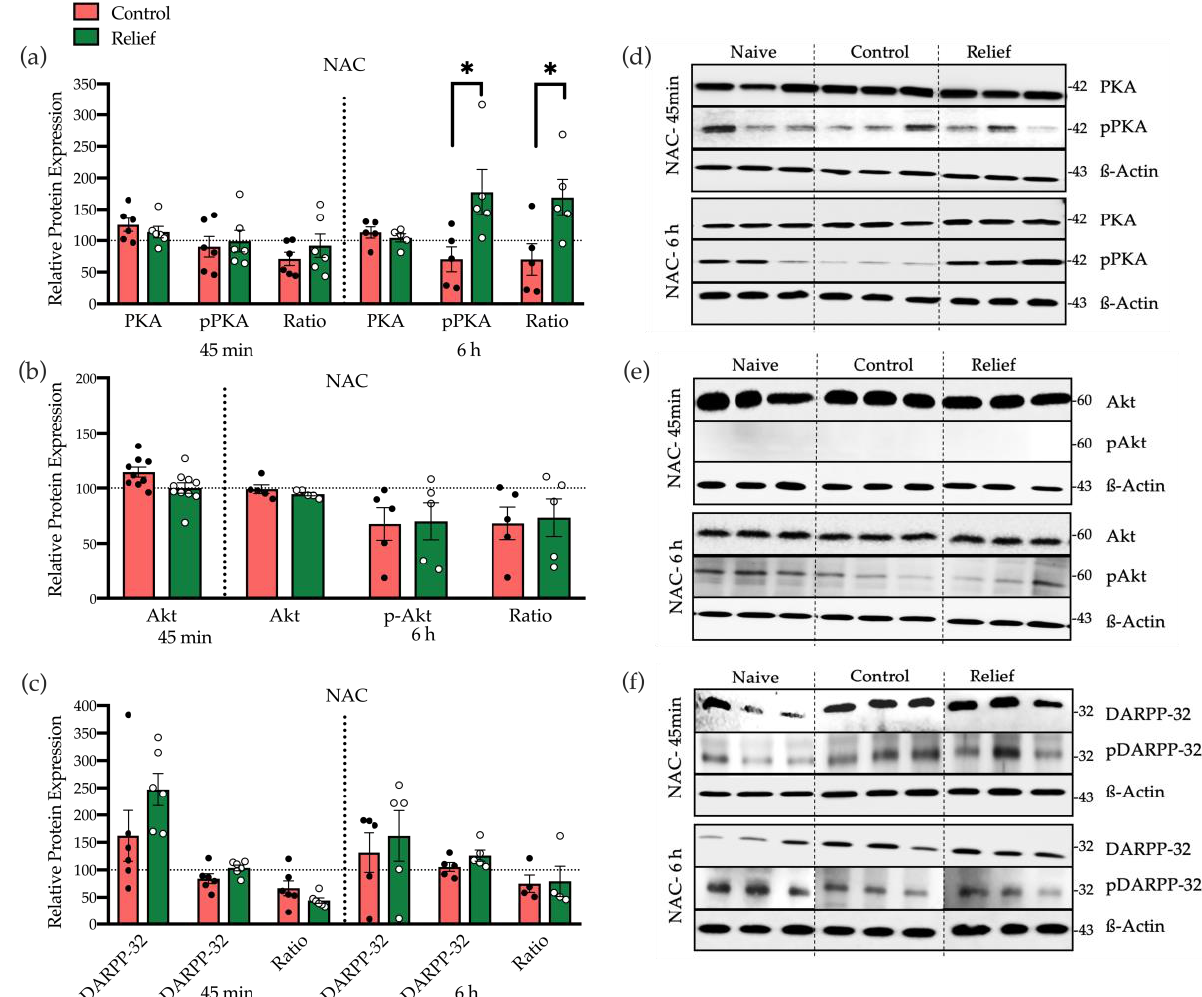
Figure 5. Expression and phosphorylation level of PKA, Akt, and DARPP-32, as well as their phosphorylation ratio in the NAC. ( a ) PKA phosphorylation and the phosphorylation ratio were significantly increased 6 h after relief conditioning in NAC. ( b ) The expression level of Akt was not affected after 45 min and 6 h after relief conditioning. No signal of pAkt was detected 45 min after conditioning while after 6 h the phosphorylation levels of the relief and control groups were not different. ( c ) DARPP-32 expression and phosphorylation levels were not affected by relief conditioning in the relief group compared to the control group. ( d – f ) Representative Western blot, showing the expression and phosphorylation levels of PKA, Akt, and DARPP-32, 45 min and 6 h following control or relief conditioning in NAC (3 different biological samples/group). Bar diagrams depict the mean ± SEM ( n = 5–6/group; * p ≤ 0.05).